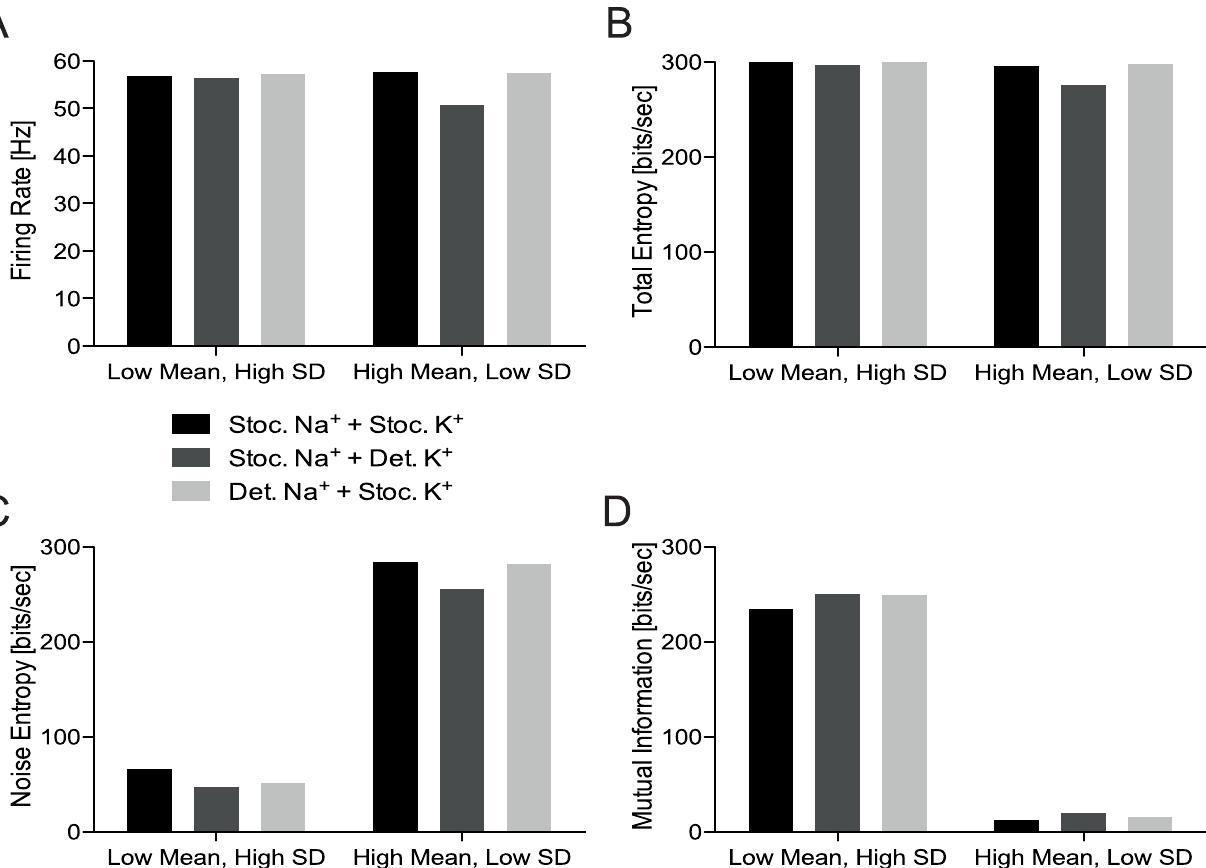
Figure 4. The information rates of the spiking neuron model are robust to voltage-gated ion channel noise. A. The firing rates of the spiking neuron model (stochastic voltage-gated Na + and K + channels), a modified model with stochastic voltage-gated Na + and deterministic voltage- gated K + channels and a modified model with deterministic voltage-gated Na + and stochastic voltage-gated K + channels evoked by low mean, high standard deviation or high mean, low standard deviation input stimuli. B. The total entropy, C. The noise entropy, and D. The mutual information rates of the same models shown in A evoked by the same stimuli.